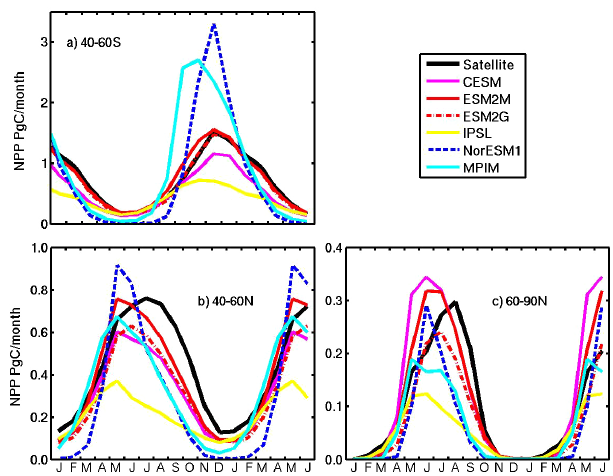
Figure 6. Comparison of the NPP (PgC month) mean annual cy- cle as simulated by ESMs and satellite-derived observations inte- grated over (a) 40–60 ◦ S, (b) 40–60 ◦ N, (c) 60–90 ◦ N. The satellite data are from SPGANT Laws (2004) model in panel (a) and VGPM Dunne model in panels (b–c)